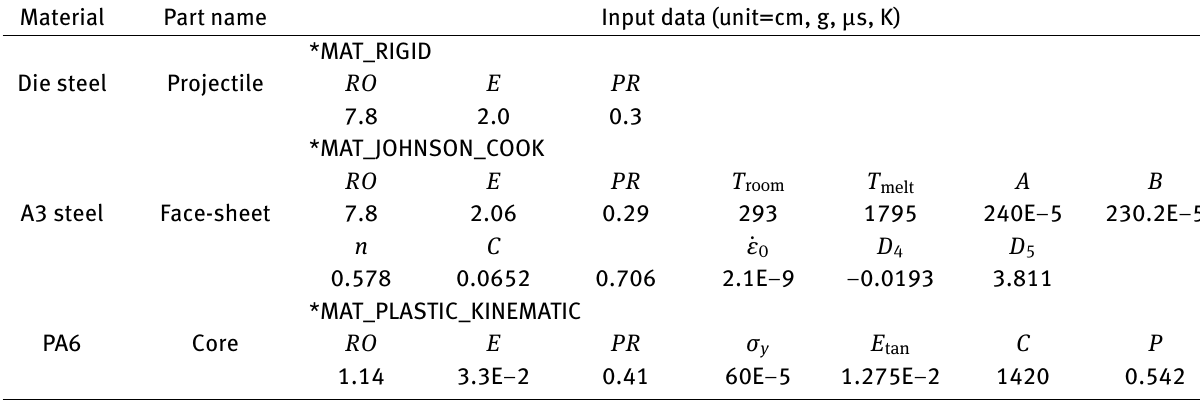
Table 4: Input data in the numerical simulation Ref. [23]